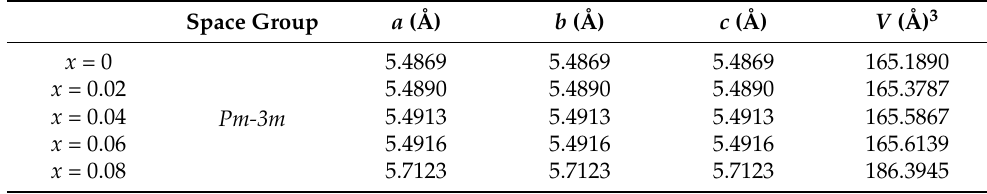
Table 1. Lattice parameters and unit cell volumes of LBCM x .